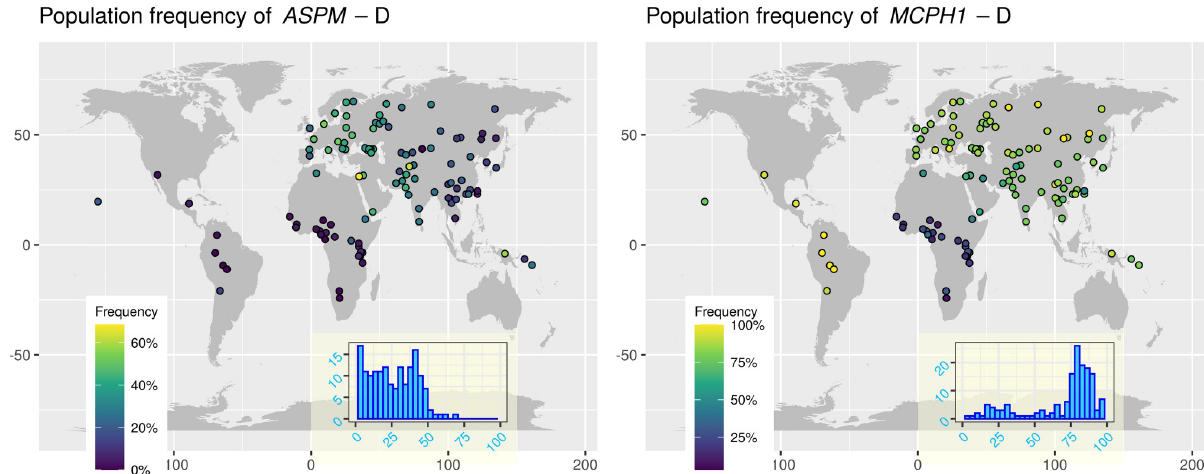
Fig 1. The distribution of the two “derived” alleles in the newer data. Left: ASPM -D, right: MCPH1 -D. Each circle on the maps represents a unique sample, and its colour represents the frequency (%) of the “derived” allele in that sample. The inset shows the overall histogram of the allele frequency across all the samples. Please note that the maximum percentage (corresponding to the lightest colour) differs between the two panels. The maps were generated with the R package maps which uses public domain data from the Natural Earth project https://www.naturalearthdata.com/.